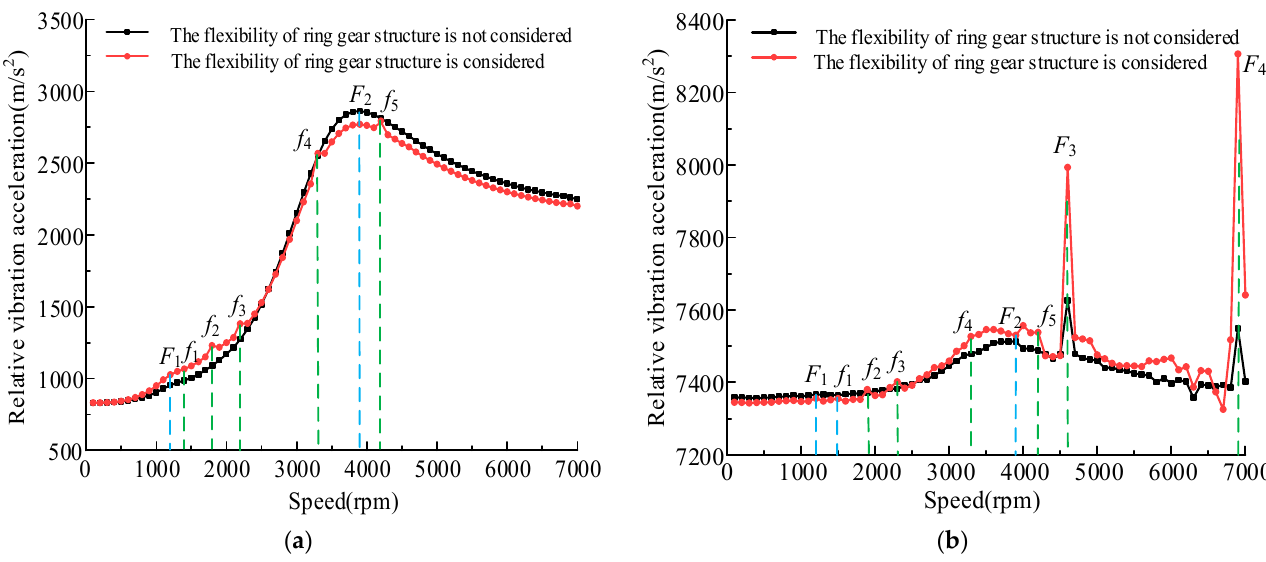
Figure 12. Trend of root mean square value of relative vibration acceleration with speed. ( a ) External meshing pair and ( b ) internal meshing